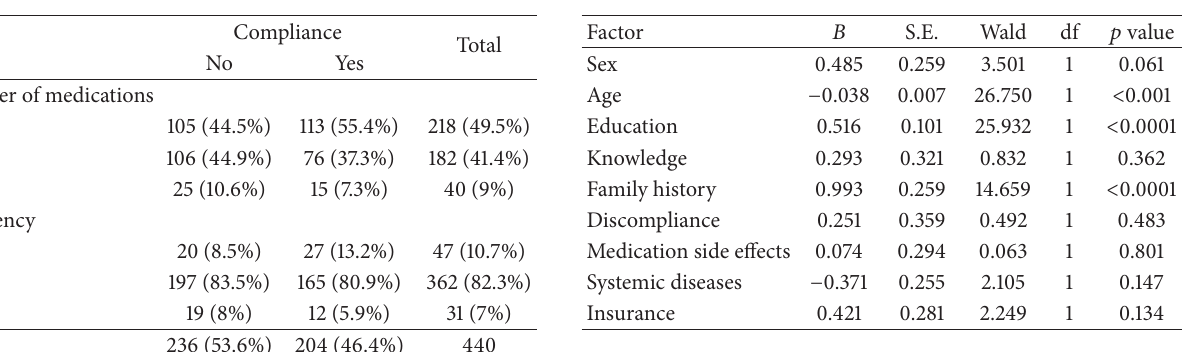
Table 4: Effect of number of medications and frequency of drops on compliance to antiglaucoma medication.